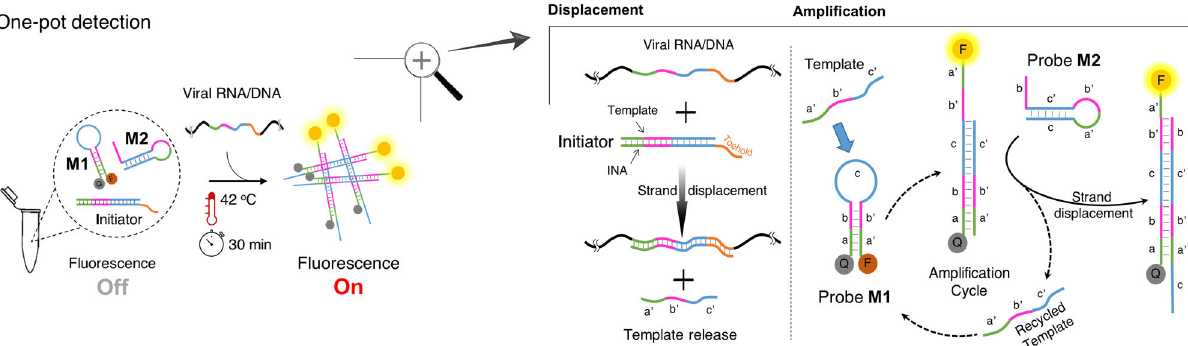
Fig. 1 NISDA assay for rapid detection of SARS-CoV-2 RNA. The reaction mixture contains three key components, including a DNA duplex (the Initiator), and two DNA molecular beacon structures (probe M1 and probe M2). In presence of viral RNA/DNA, toehold-mediated template displacement and cascade signal ampli fi cation occur sequentially, following by fl uorescence detection after 30 min at 42 °C. INA is intercalating nucleic acid with enhanced binding af fi nity. F and Q denote for 6-Fam fl uorophore and bhq-1 quencher, respectively. Letter labels denote for domains. The domains labeled with primes are